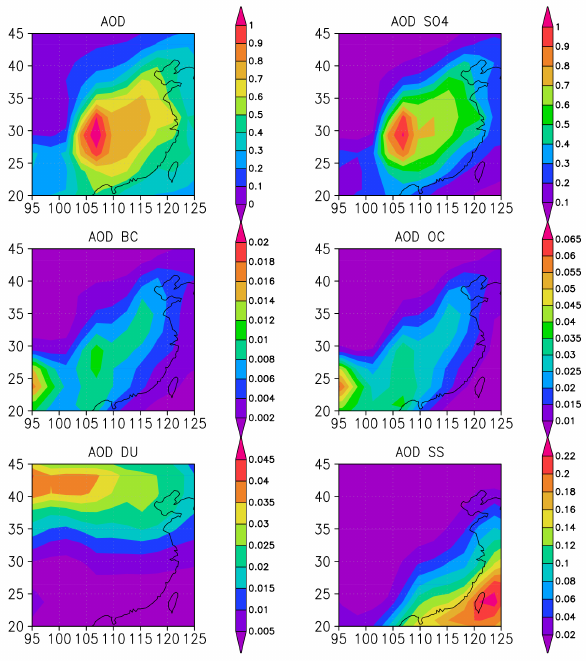
Fig. 5. Total AOD in China and contributions to it from different aerosol species (four-year average (2006–2009), unitless).